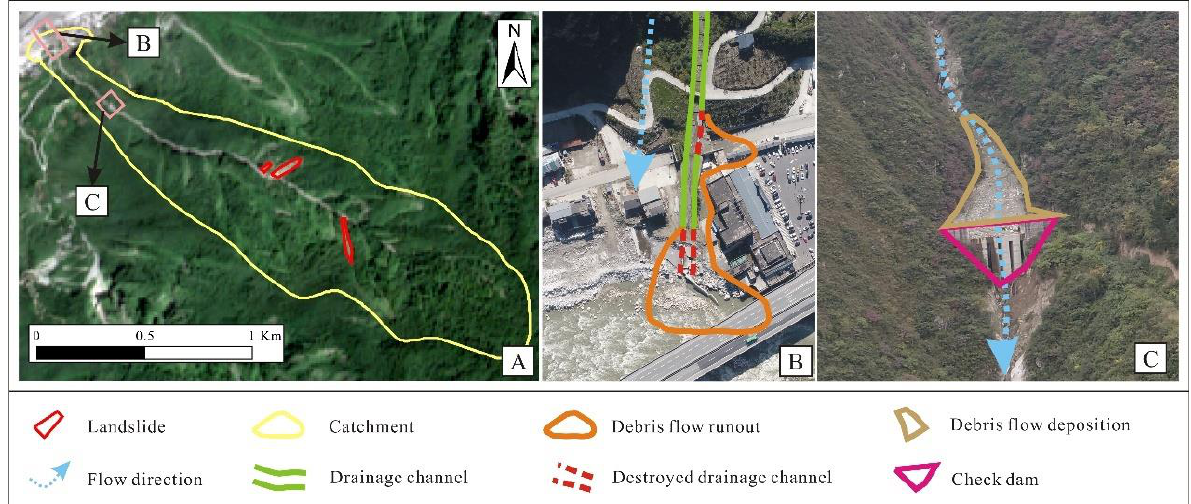
Figure 3. ( A ) The landslides are identified on a satellite image from 27 August 2020. It shows the locations of ( B , C ). ( B ) Destroyed drainage channel and debris flow runout on UAV image from 25 October 2020. ( C ) A drone photo shows that the check dam was filled with debris-flow deposits after the debris flow, and it was taken on 25 October